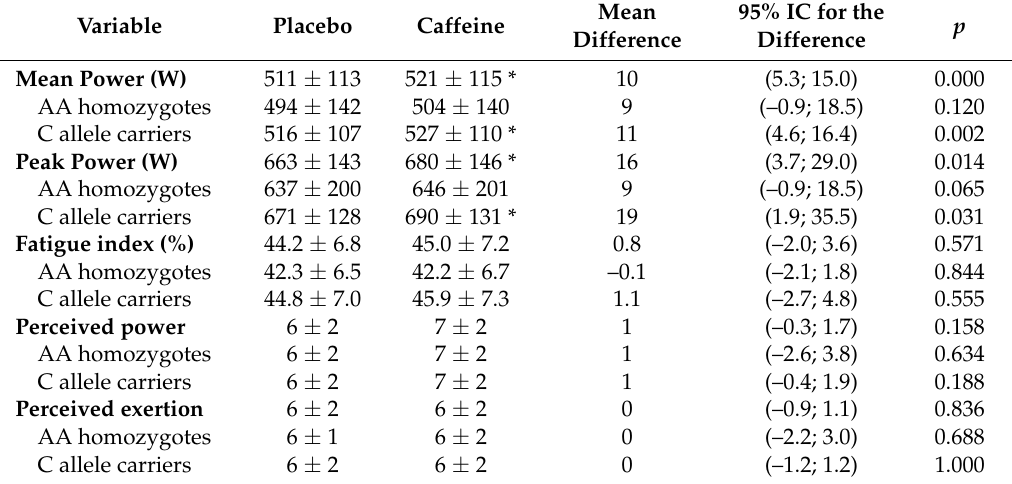
Table 2. Variables obtained during the Wingate test and subjective perception of muscle power and exertion with the ingestion of 3 mg · kg − 1 of caffeine or a placebo for AA homozygotes and C-allele carriers.